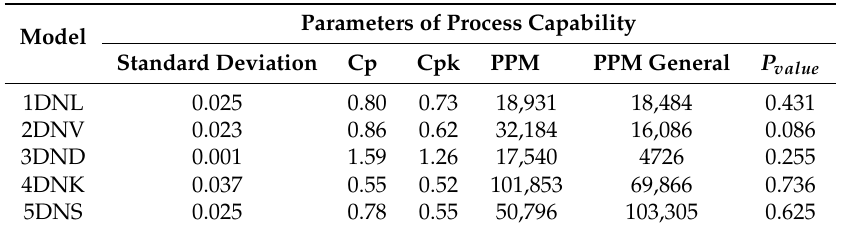
Table 12. Summary of the results of the processing capacity of each die-nozzle model.